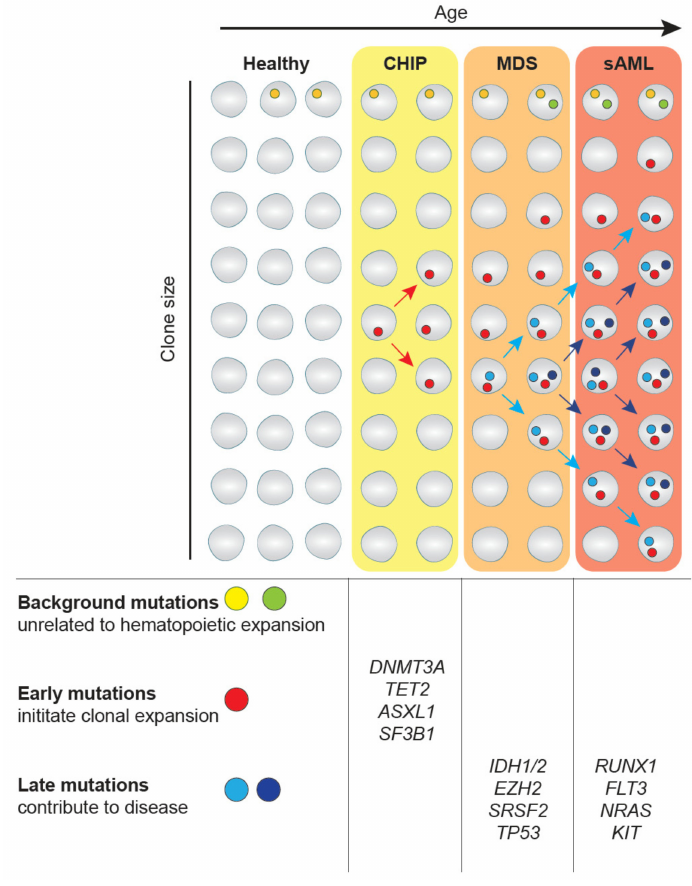
Figure 1. Clonal hematopoiesis in myelodysplastic syndromes (MDS) and transformation to sec- ondary acute myeloid leukemia (sAML). Mutations in hematopoietic stem cell (HSC) clones occur at any time of our life as part of the aging process. While most mutations are background mutations that do not affect cellular properties, some mutations provide an advantage to HSCs, such as increased self-renewal. These mutations drive clonal expansion and the eventual development of the asymp- tomatic clonal hematopoiesis of indeterminate potential (CHIP). The further expansion frequently driven by the acquisition of additional genetic alterations can lead to MDS. The gain of additional driver mutations can further lead to transformation to sAML. This figure has been inspired by